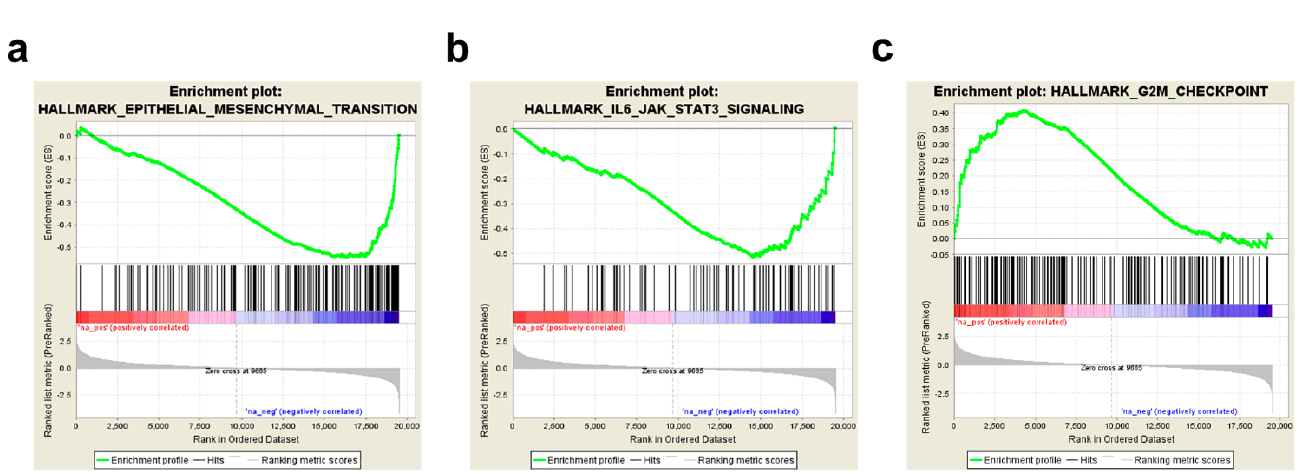
Figure 3. GSEA of the biological processes involved in vinflunine resistance in aUCC. GSEA plot for ( a ) EMT, ( b ) IL6/JAK/STAT3 and ( c ) G2M checkpoint.